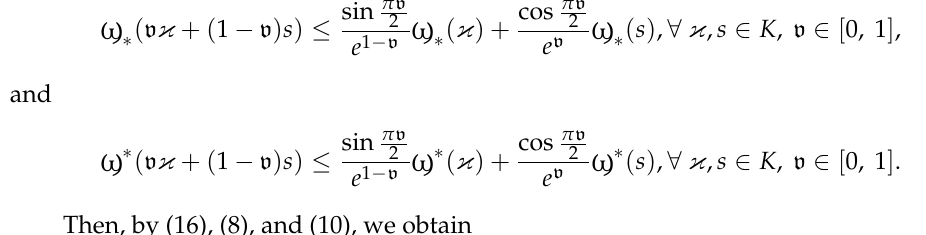
Since then, the authors of [66–76] have extensively investigated various additional im- provements to and expansions of Hermite–Hadamard inequalities for different convex fuzzy-valued functions. Additionally, in [77], some Hermite–Hadamard- and Jensen-type inequalities for up and down convex fuzzy-number-valued functions were discovered. In this study, several Hermite–Hadamard-type inequalities for interval-valued left and right exponential trigonometric functions are established. The earlier inequalities described in [78–93] are generalized by our findings. For more information, see [94–99]. mard-type inequalities as a result of [77,78,85,86]. Our findings clarify some